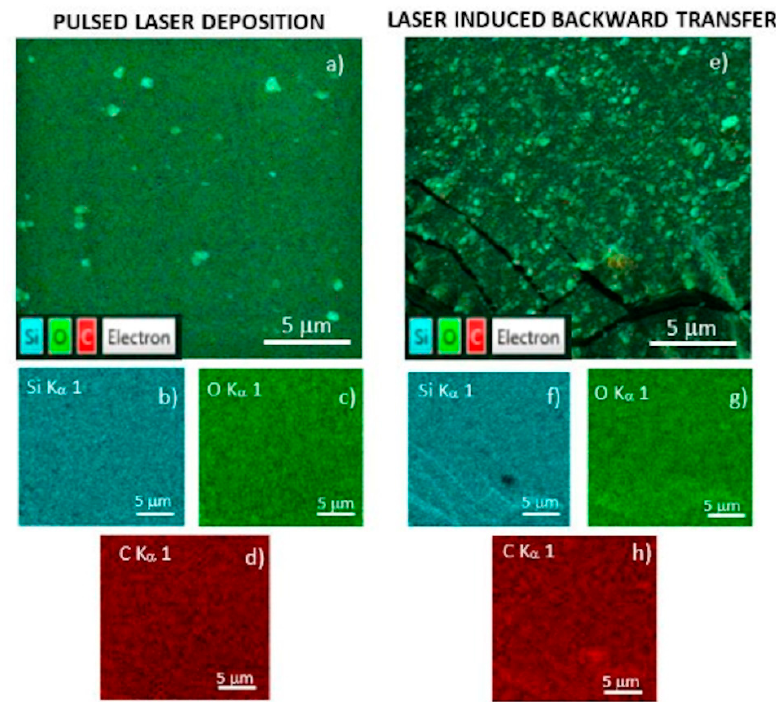
Figure 5. Energy dispersive X-ray (EDX) mapping analysis of PDMS deposited by PLD and by LIBT are displayed in two panels. On the left side of the figure are showed the maps of PDMS deposited by PLD identifying the presence of Si, O, C ( a ) and the elemental maps of Si ( b ), O ( c ), C ( d ) respectively. On the right side of the figure are showed the map of PDMS deposited by LIBT identifying the presence of Si, O, C ( e ) and the elemental maps of Si ( f ), O ( g ) and C ( h ) respectively.